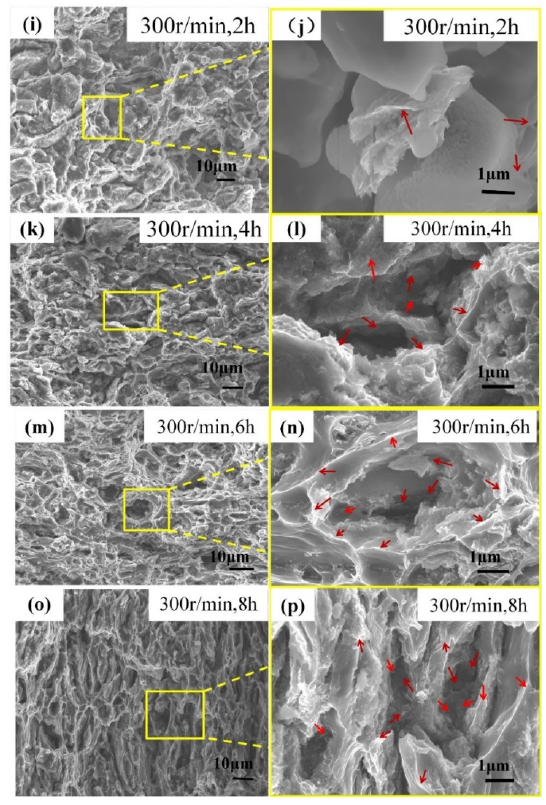
Figure 16. Tensile fracture morphology of the 0.5 wt.% GNP/Al composites.